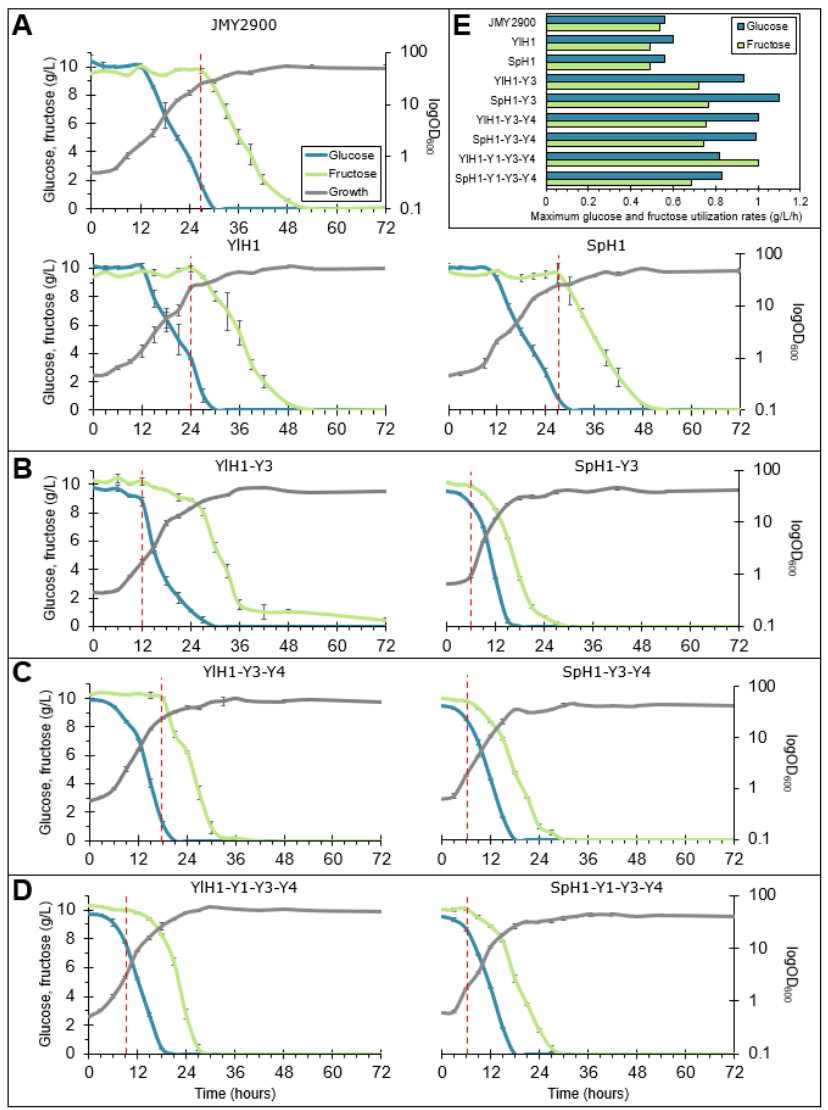
Figure 2. Growth and substrate utilization profiles of the Y. lipolytica transformants expressing combinations of hexokinases and hexose transporters in flasks in a defined medium containing a mixture of glucose and fructose ( A – D ). Maximum glucose and fructose utilization rates ( E ). Red vertical dashed lines indicate onset of fructose utilization. The cultivations were performed in three biological replicates.